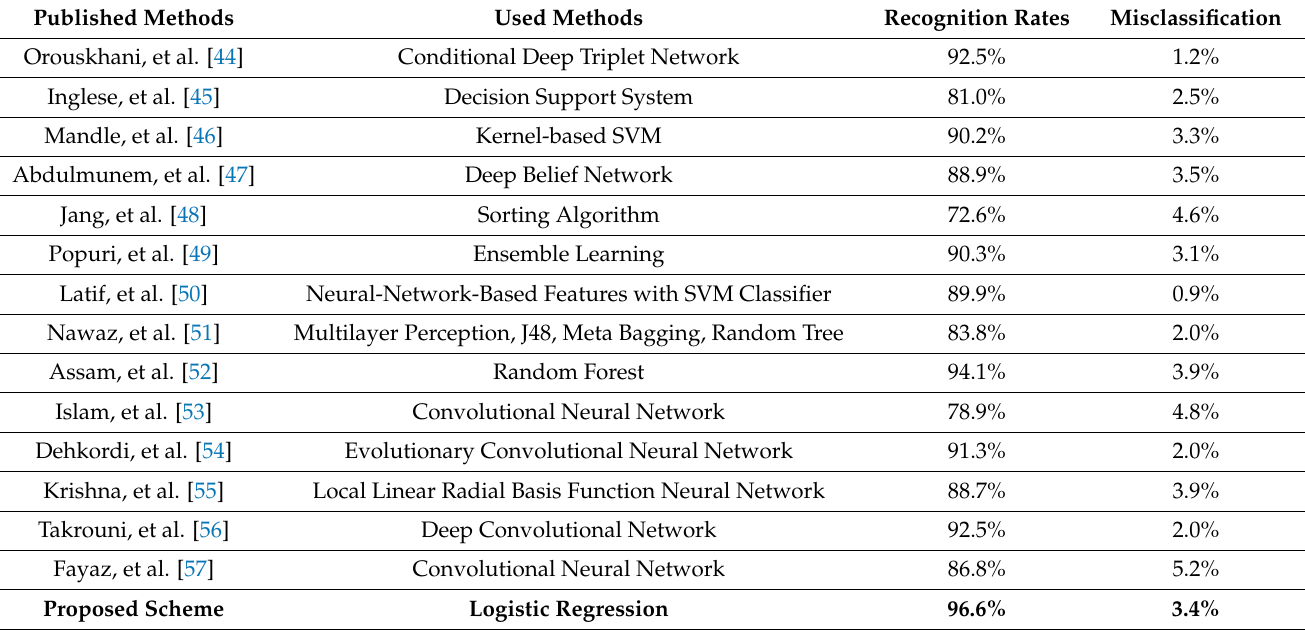
Table 9. Performance comparison of the state-of-the-art methods against the proposed approach on MRI brain dataset (Number of utilized images 595 (where, normal = 115, and abnormal = 480)).